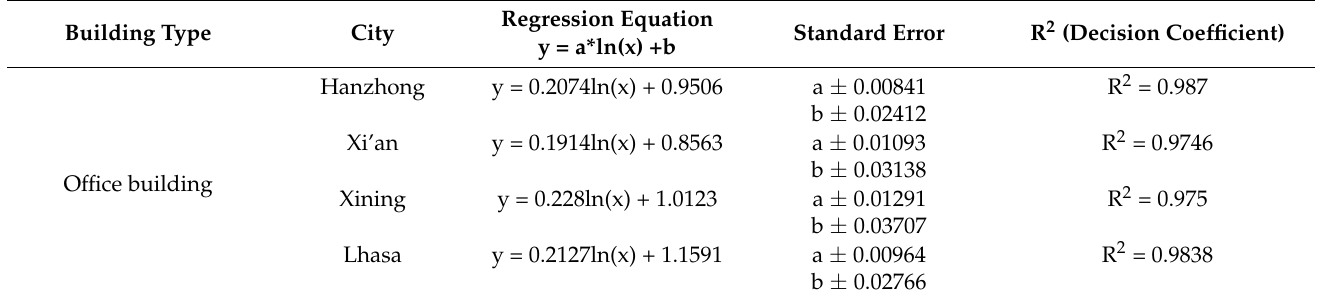
Table A1. The mathematical model established when F is the independent